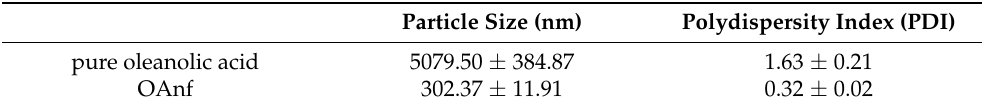
Table 2. Diameters of oleanolic acid and its nanofibers detected by laser particle size analyzer. Results are shown as mean ± SD of three independent experiments.